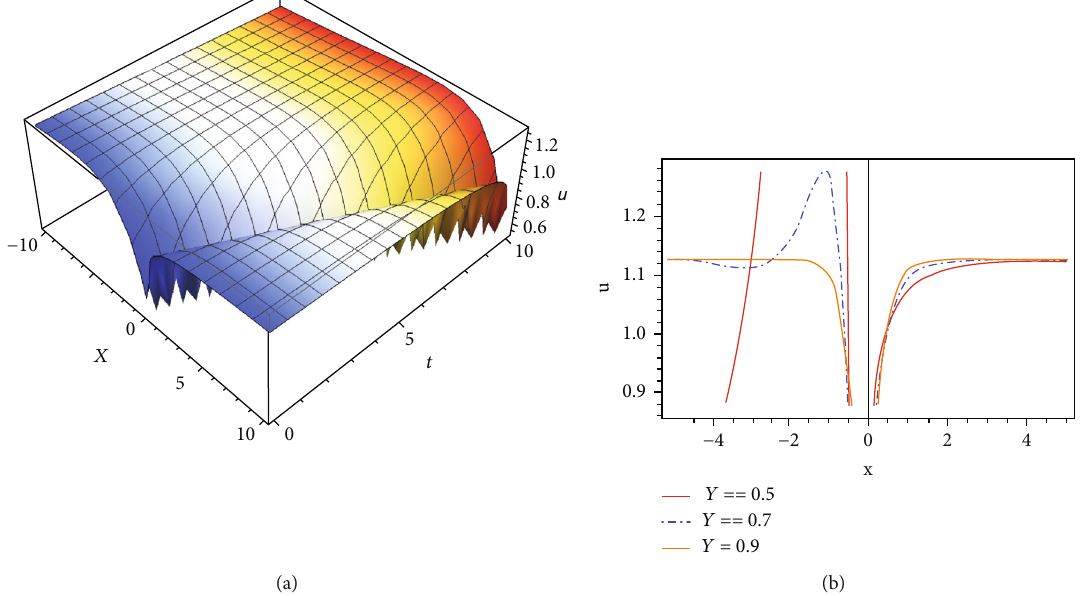
= 1 , T = 2 , V = 1 , c = 3 , a = 1 , b = 1 , and γ = 0 : 5,0 : 7,0 : 9 . for the solution u 1